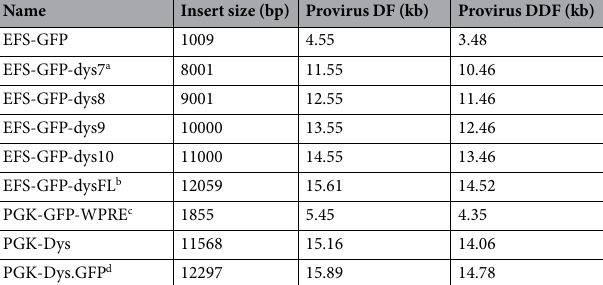
Table 1. FVV transfer plasmid inserts and the resulting provirus size. a The numbers [-dys(n)] correspond to the length of 5 ′ dystrophin ORF in kb. b FL indicates inclusion of the full-length ORF. c WPRE - woodchuck hepatitis virus post-transcriptional regulatory element. d Dys.GFP encodes a full-length dystrophin-GFP fusion